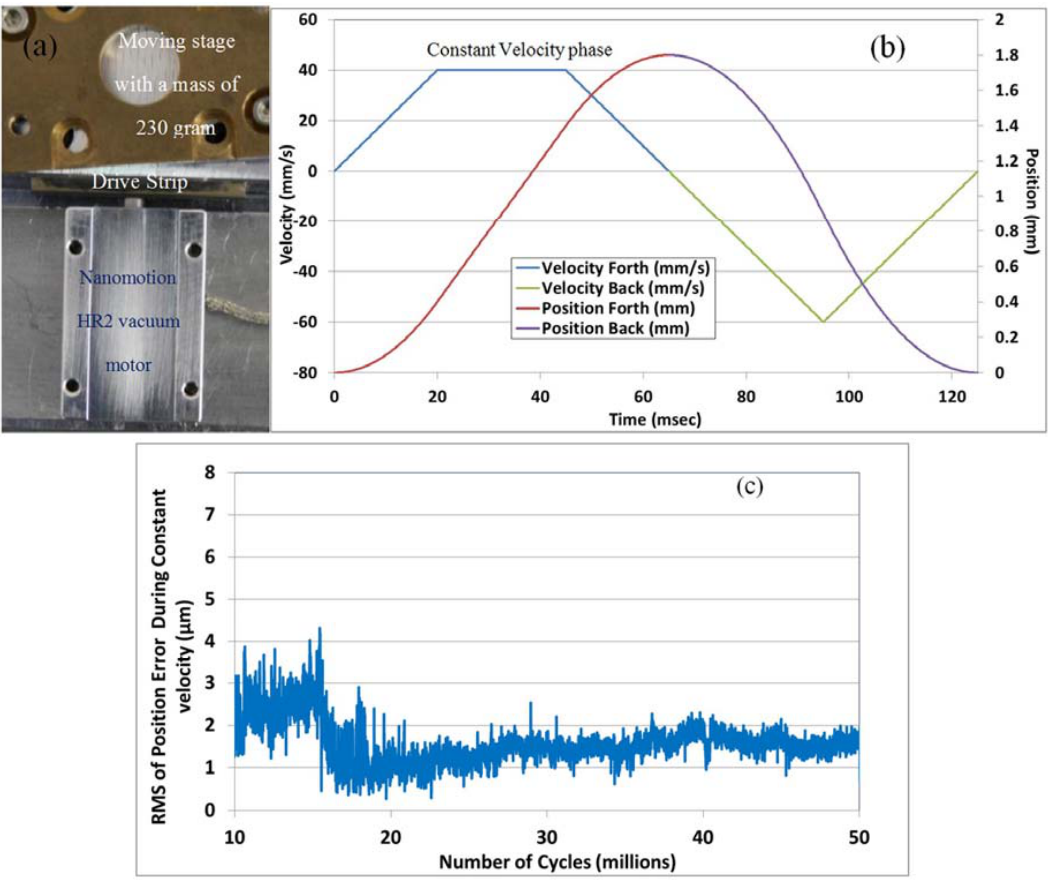
Figure 11. Vacuum operation of a scanning stage: ( a ) Image of the setup including an HR2 vacuum motor and a linear stage having a moving mass of 230 g. ( b ) Motion profile during a single scanning cycle. ( c ) Position error rms, as function of the number of performed scanning cycles.